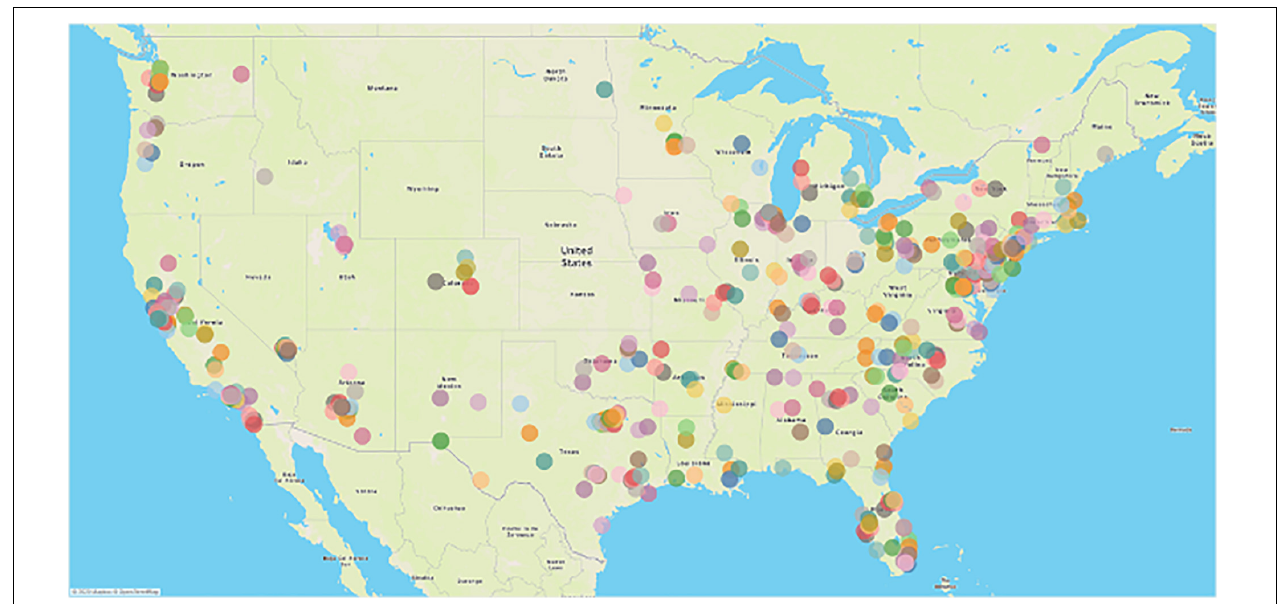
FIGURE 1 | Visualization of zip code analysis of survey respondents. Color represents different zip codes in the 48 contiguous states in the United